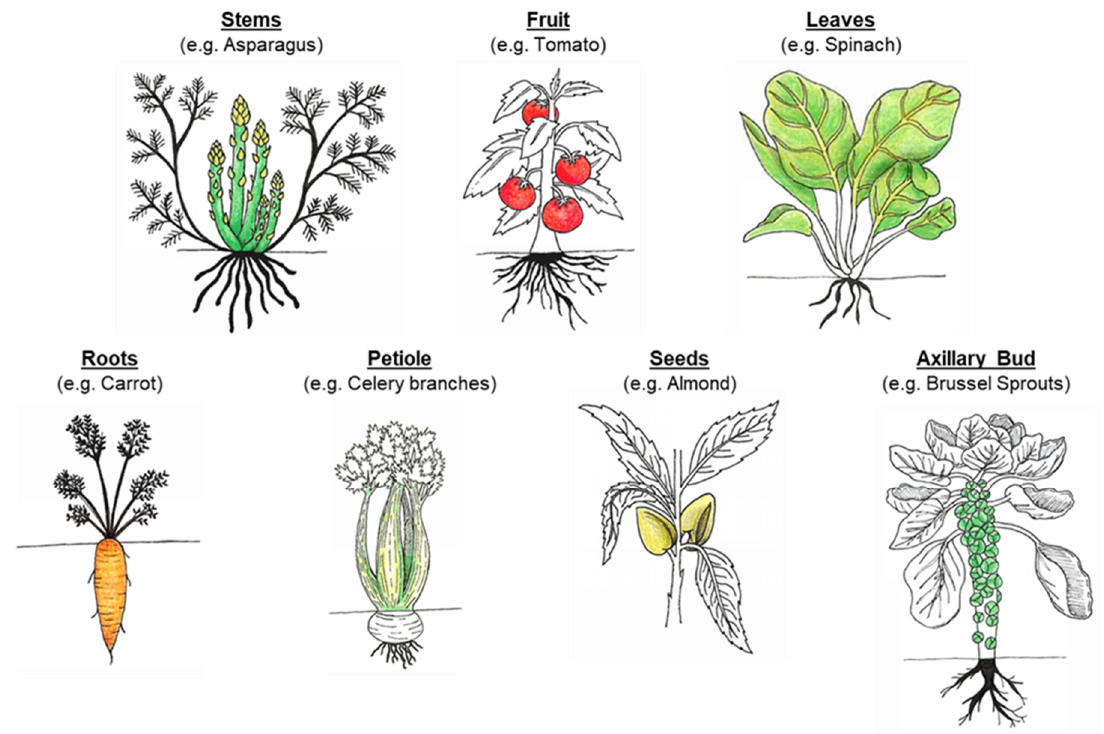
Figure 1. Examples of fruits and vegetables derived from different plant organs/tissues .